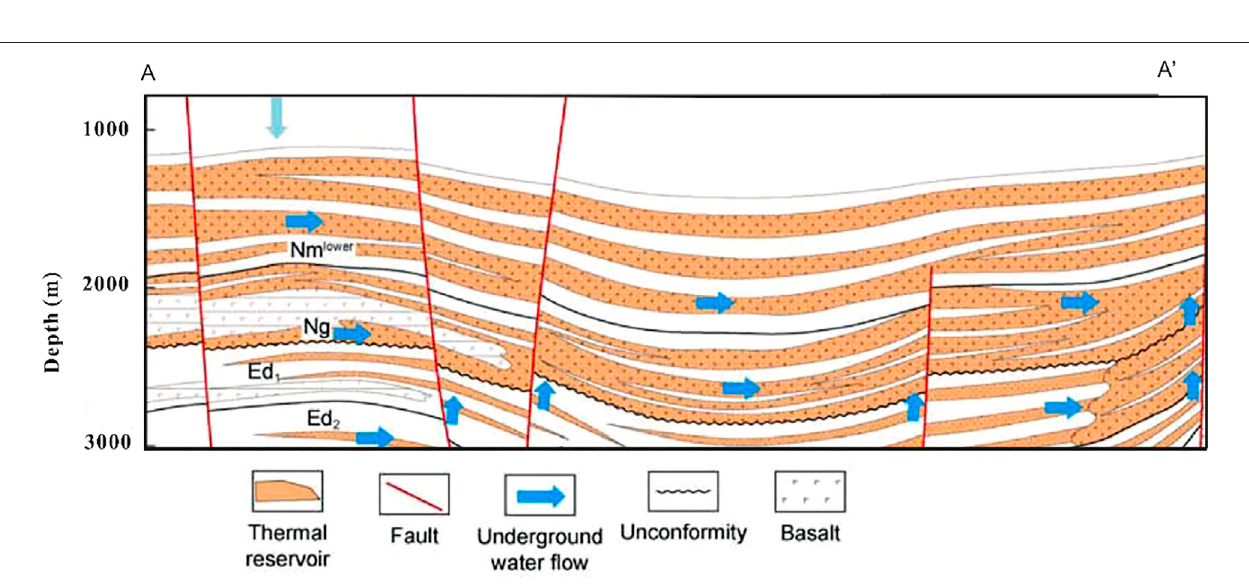
Frontiers in Earth Science |